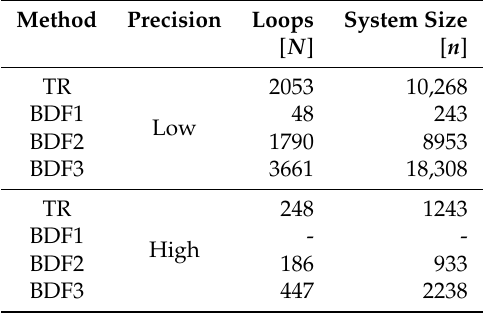
Table 13. Scalable RLC circuit: Maximum system size compatible with RT execution on the PC simulation environment.